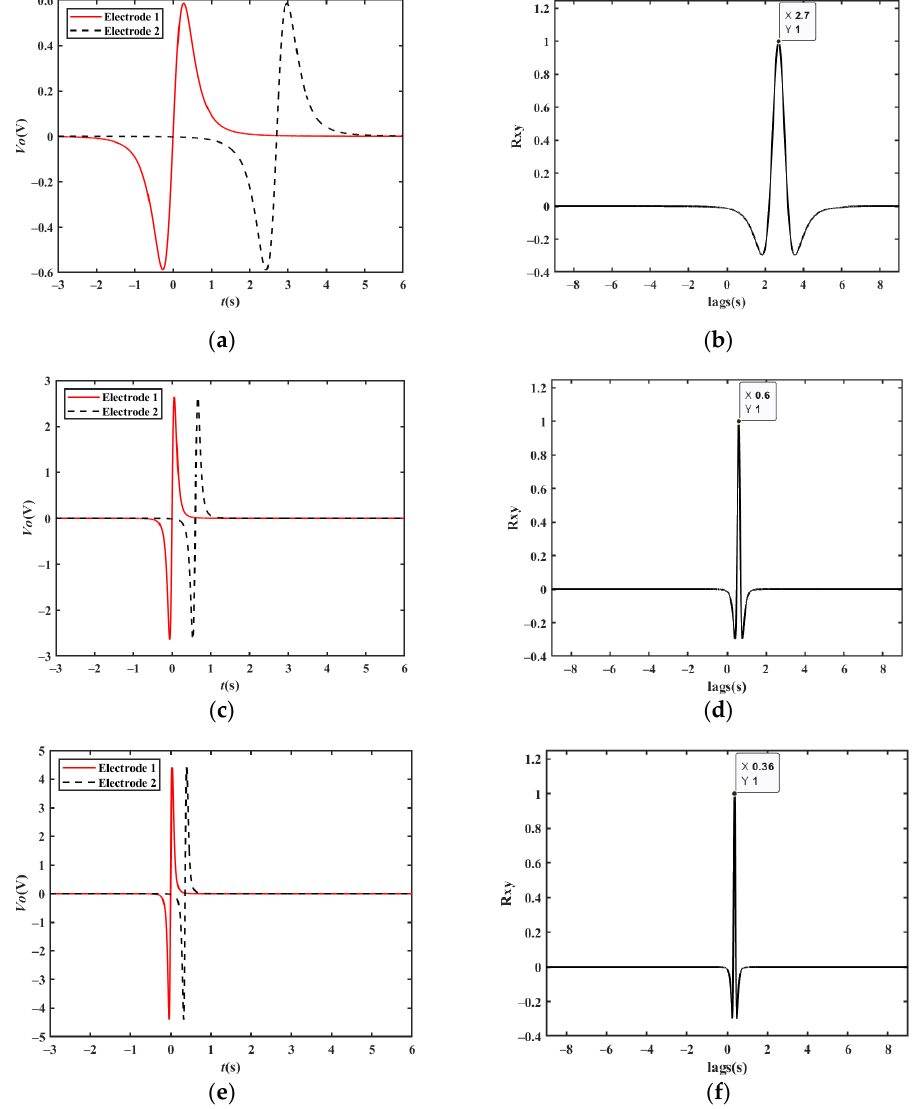
Figure 11. Simulation results of a single vehicle passing by two electrodes: ( a ) simulation results at a velocity of 20 km/h; ( b ) cross-correlation results at a velocity of 20 km/h; ( c ) simulation results at a velocity of 90 km/h; ( d ) cross-correlation results at a velocity of 90 km/h; ( e ) simulation results at a velocity of 150 km/h; ( f ) cross-correlation results at a velocity of 150